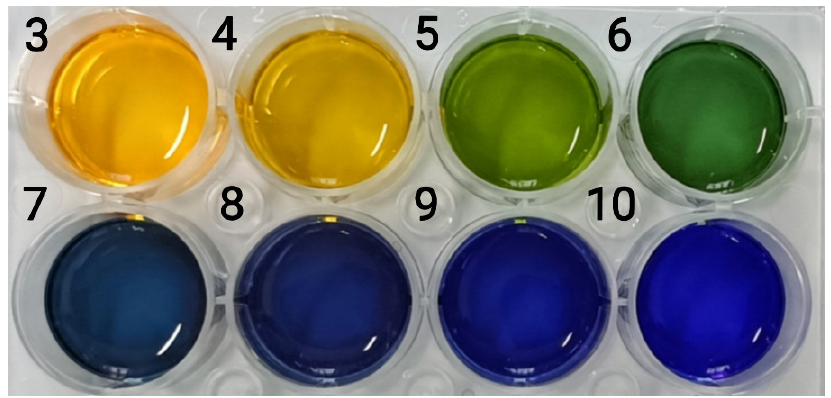
Figure 10. Color of the nanocapsule suspension at pH 3–10 (the numbers represent pH values).